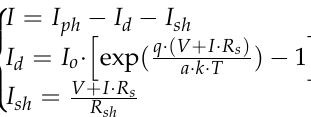
Figure 1. Equivalent circuit diagram for SDM.